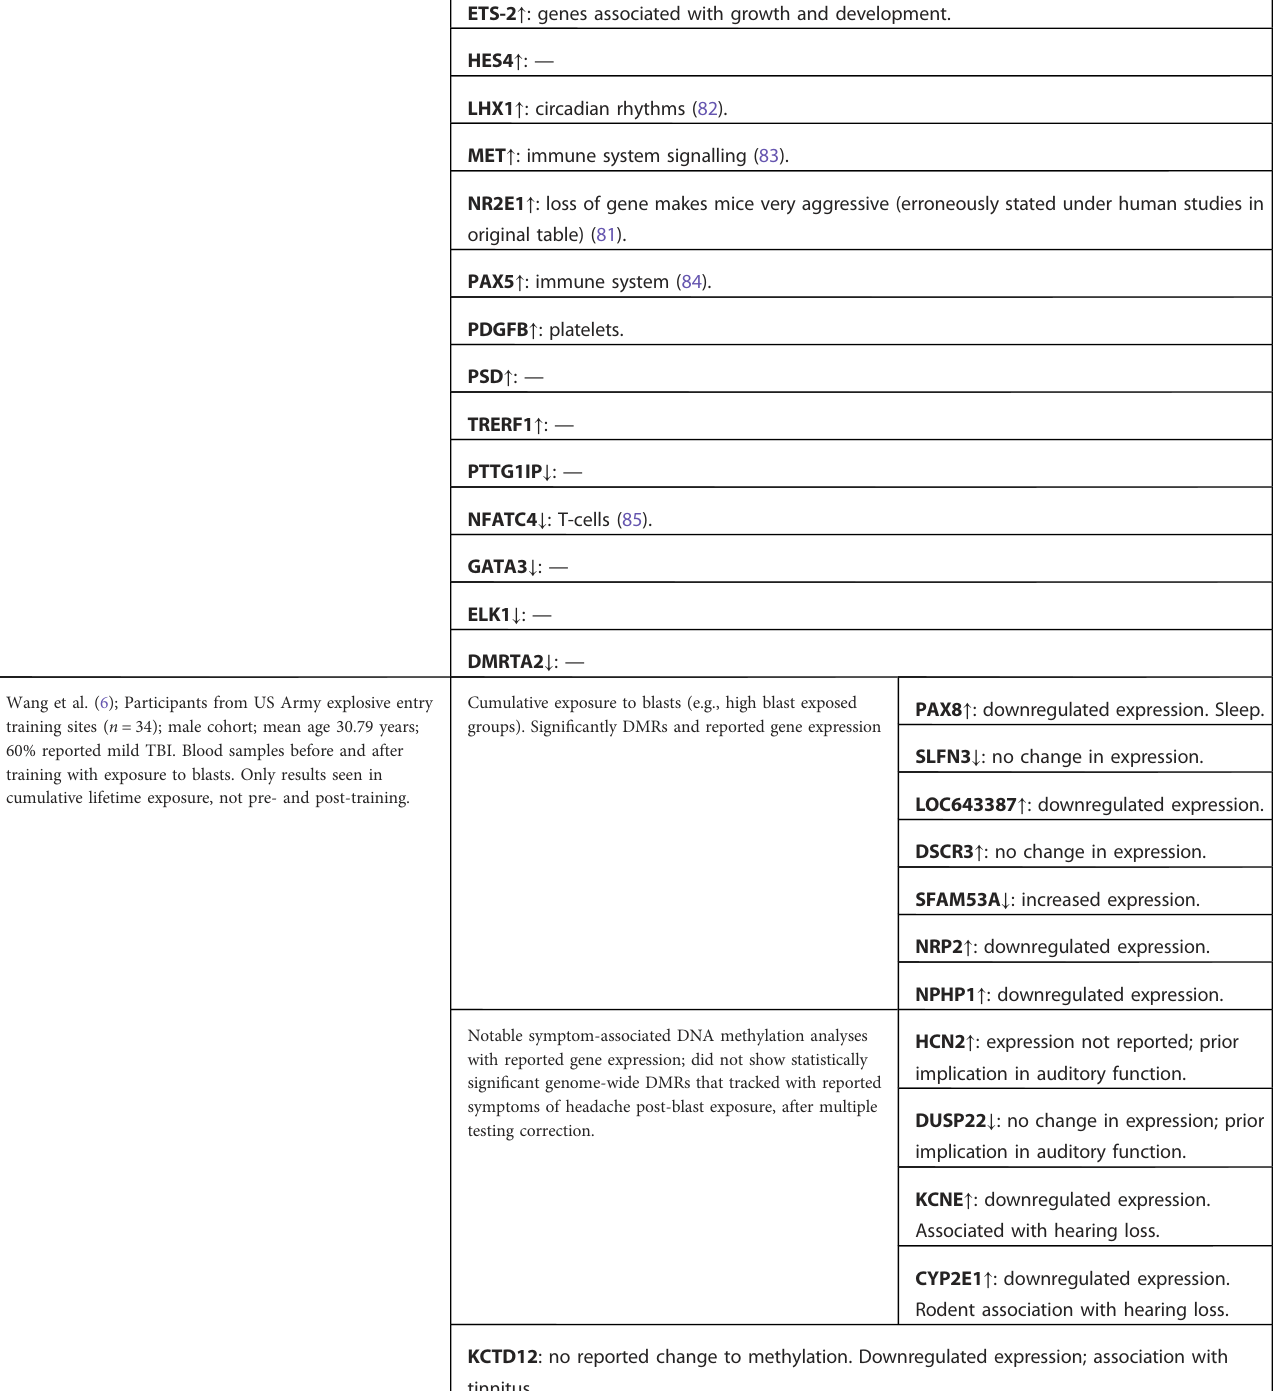
TABLE 1 Exposure to war and subsequent effects on epigenetics to individuals measured through gene methylation. Study Gene implicated and methylation/expression status Hammamieh et al. (81); veterans with PTSD ( n =99) and without ( n =101). Age range 20 – 60 years. Cohort of men only. Individuals with TBI, neurologic disorder and psychiatric history excluded. Blood samples showing